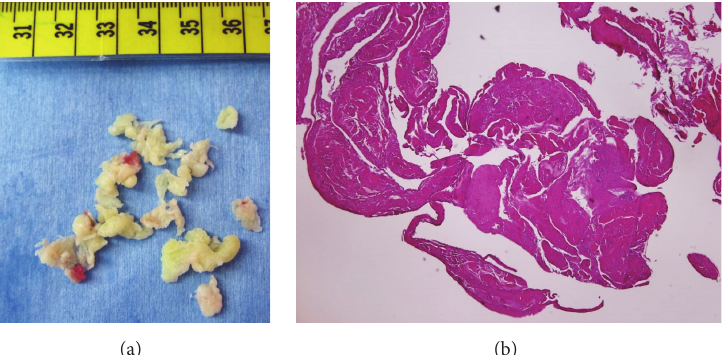
Figure 3: Photographs of gross (a) and histologic (magnification × 40) (b) findings of the material inside the cyst. Fragments of necrotic synovial villi with fibrinoid degeneration are